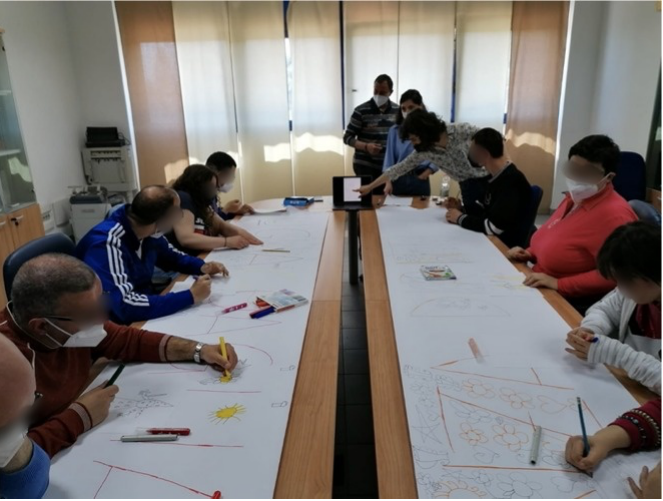
Figure 1. The Art Therapy